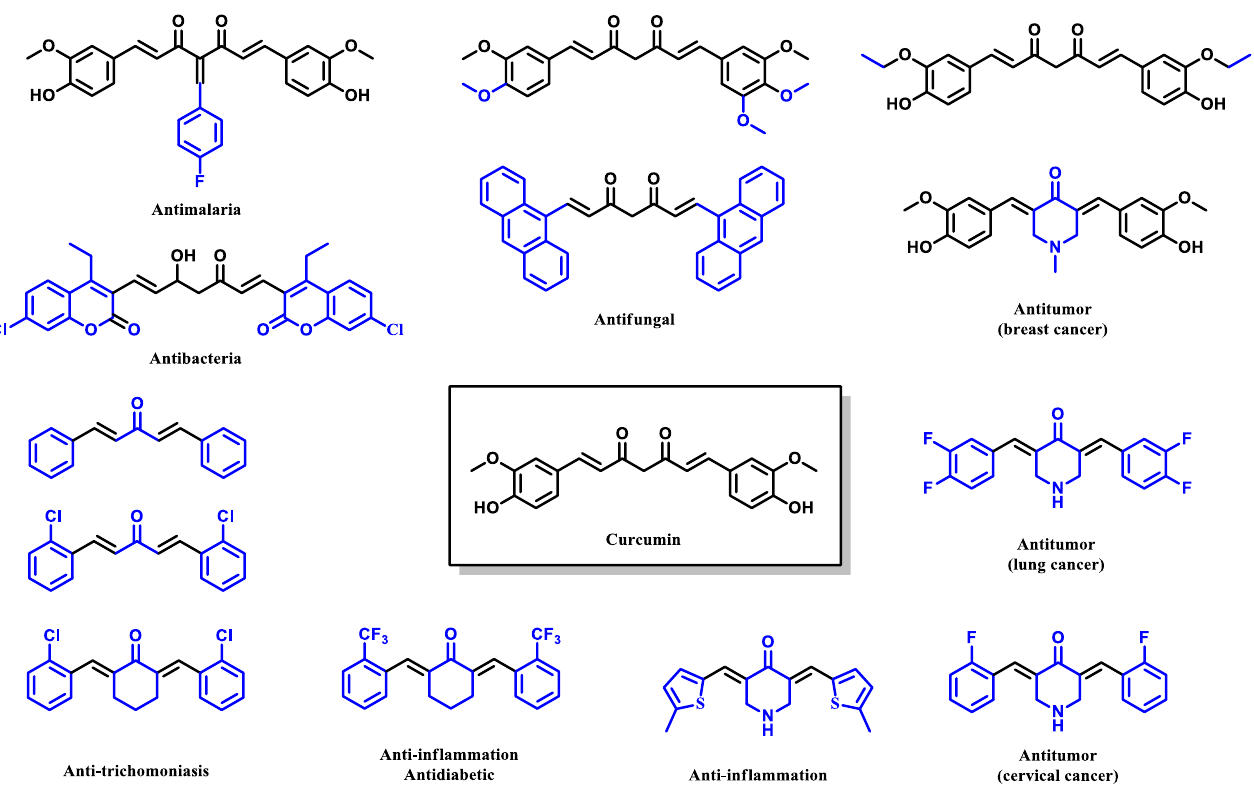
Figure 8. Examples of curcumin derivatives with a wide range of therapeutic properties [9,38,50,55–61].